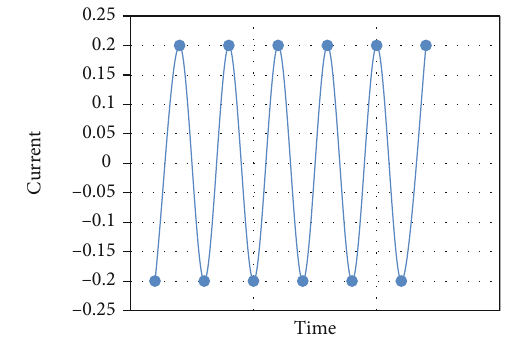
Figure 13: Three-phase current.